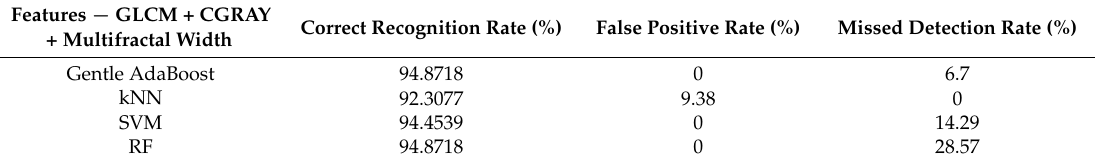
Table 8. Experimental results of constructing different recognition models based on GLCM + CGRAY + multifractal width